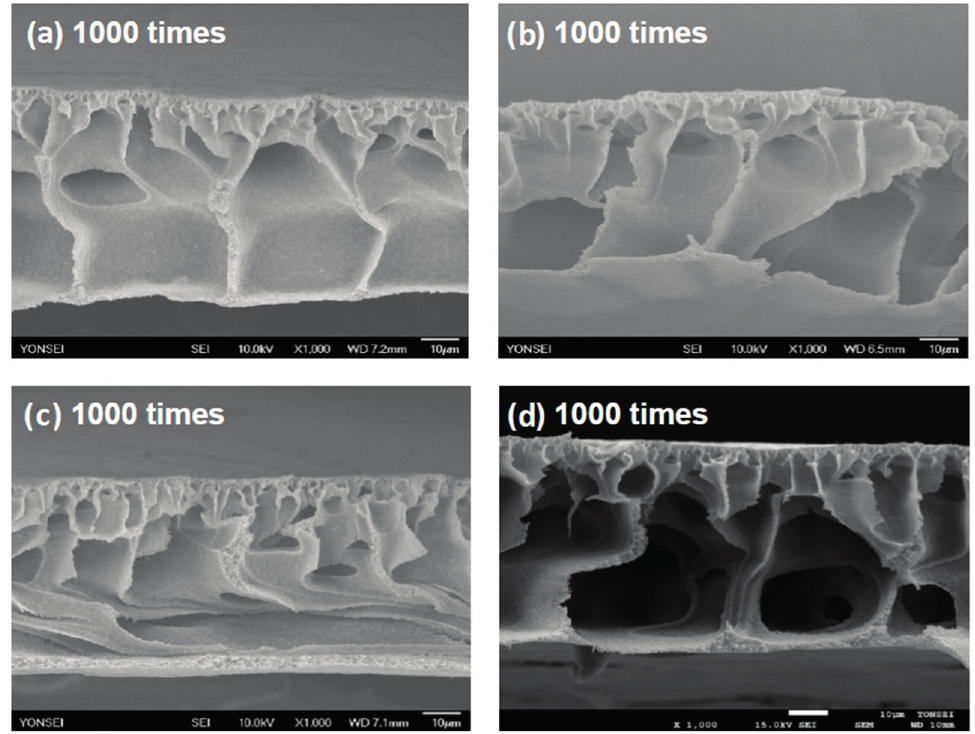
Figure 7. SEM images: cross-section of ( a ) A-1; ( b ) A-2; ( c ) B-1 and ( d ) B-2